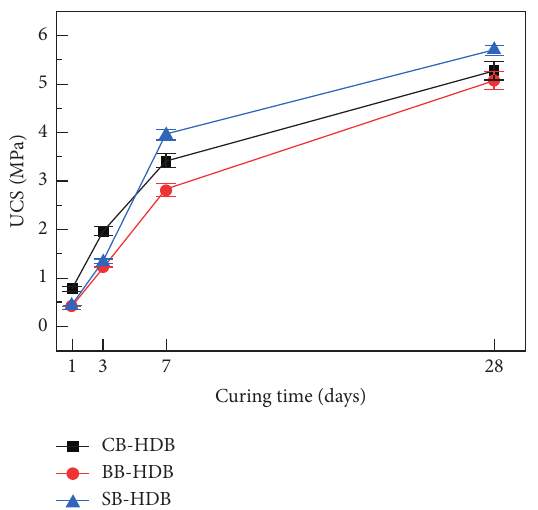
Figure 2: UCS developments for CB-HDB, BB-HDB, and SB-